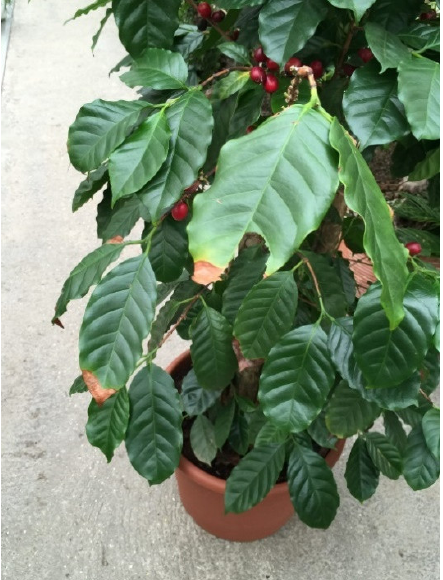
Figure 2. Symptomatic ornamental coffee ( Coffea arabica L.) plant introduced in 2015 in Italy from Costa Rica, intercepted by the regional phytosanitary service of the Regione Veneto, and resulted positive for Xylella fastidiosa upon detection. The plant was destroyed immediately after the detection. (Reproduced with permission of the regional phytosanitary service of Regione Veneto).